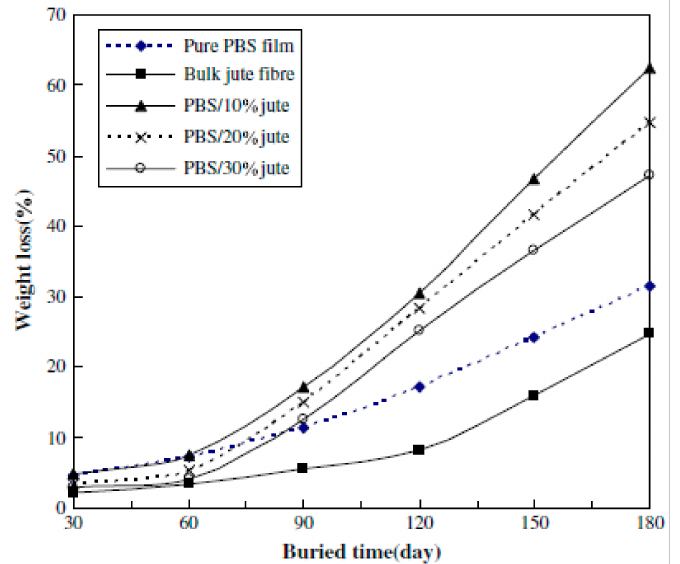
Figure 20. Weight loss of buried pure PBS film, bulk jute fiber and PBS/jute fiber composites at various fiber contents [103].